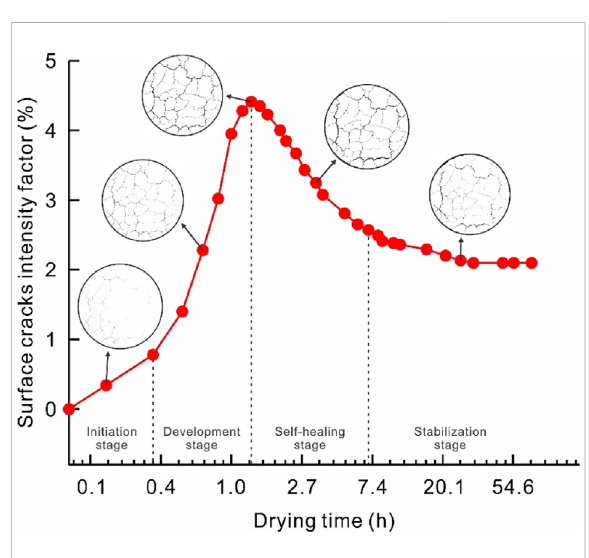
FIGURE 8 Evolution stage of cracks on specimen surface during